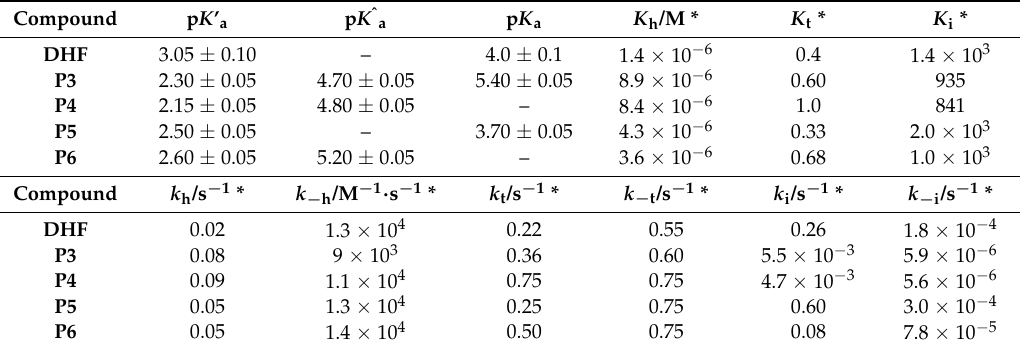
Table 1. Complete sets of thermodynamic and kinetic rate constants characterizing the multistate of the pigments investigated in this work.